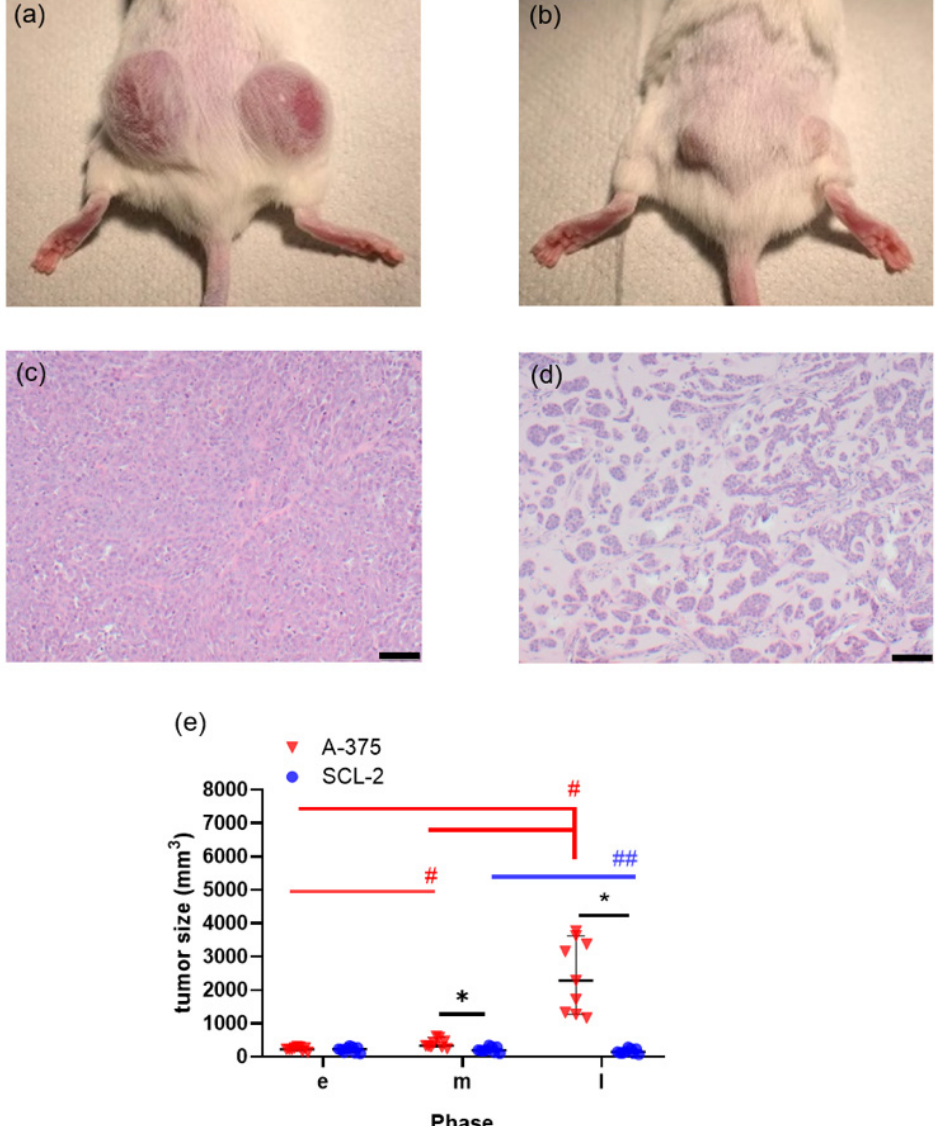
Figure 1. Characterization of A-375 and SCL-2 cell-induced tumors. Morphology of A-375 cell ( a ) and SCL-2 cell ( b ) induced tumors in the late phase after cell injection. Histology of A-375 cell ( c ) and SCL-2 cell tumors ( d ) after hematoxylin and eosin staining; scale bar = 50 µ m. ( e ) The sum of tumor size (left flank tumor + right flank tumor) during early ( e ), middle (m) and late (l) phase of tumor growth. * p ≤ 0.0116, # p ≤ 0.0091, ## p = 0.0003; A-375: n = 9, SCL-2: n = 9.